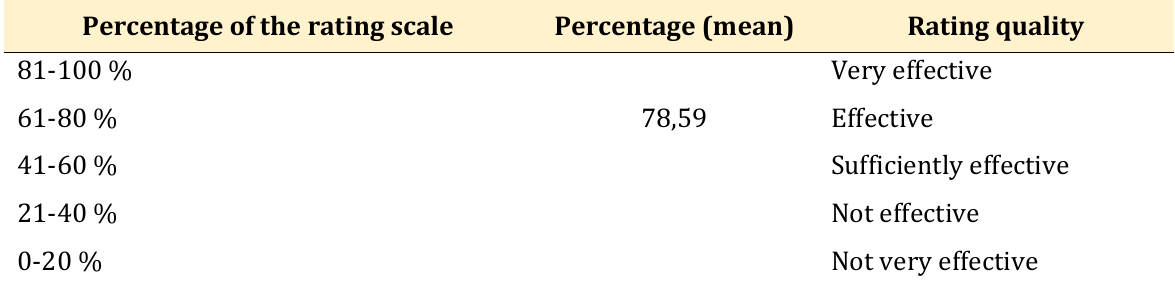
Table 6: The Result of Percentage in Speaking